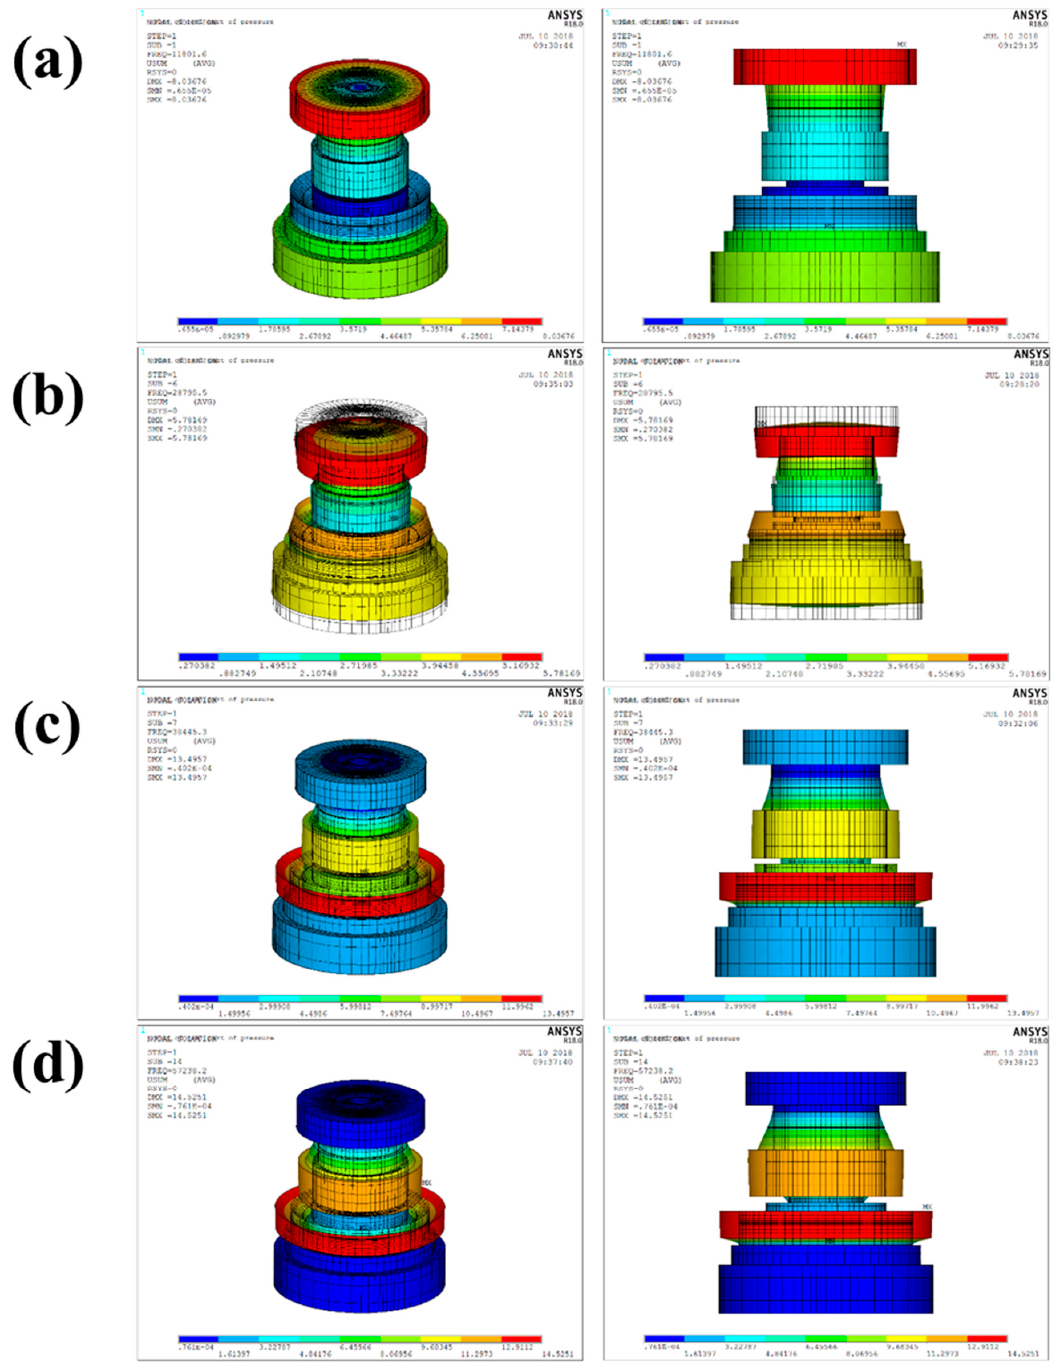
Figure 2. Modal analysis results under a free condition for the sensor module in Figure 1: ( a ) the primary resonance mode; ( b ) the second resonance mode; ( c ) the third resonance mode; ( d ) the fourth resonance mode.